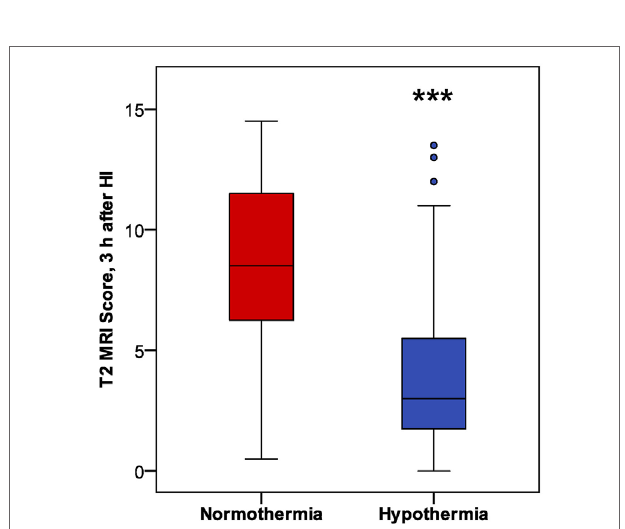
FigUre 4 | Phase 2: early detection of hypothermic neuroprotection in T2 magnetic resonance imaging, 3 h after HI ( n = 31 in each treatment group; *** p < 0.001, Mann–Whitney U -test).